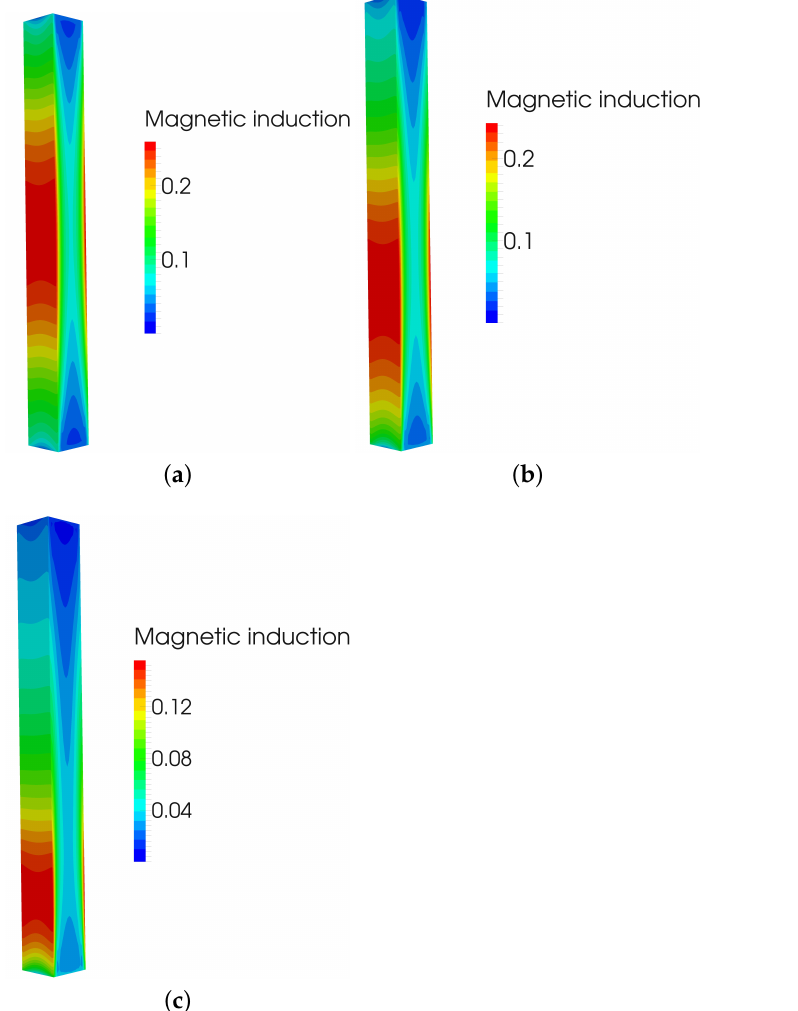
Figure 6. ( a ) Magnetic induction at position 1 = 0 mm; ( b ) Magnetic induction at position 2 = 20 mm; and ( c ) Magnetic induction at position 3 = 50